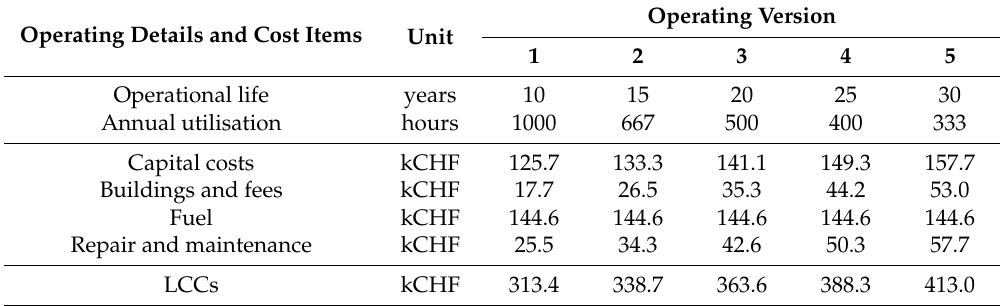
Table 1. Life-cycle costs for five operating versions with a discount rate of 0% (present